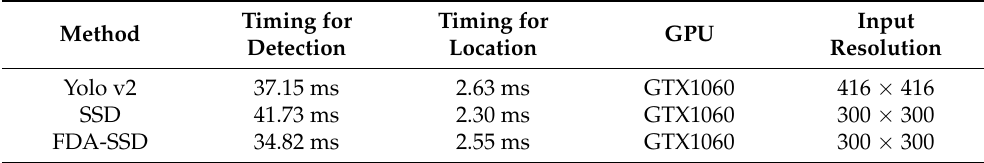
Table 4. Comparison of timing performance in experiment